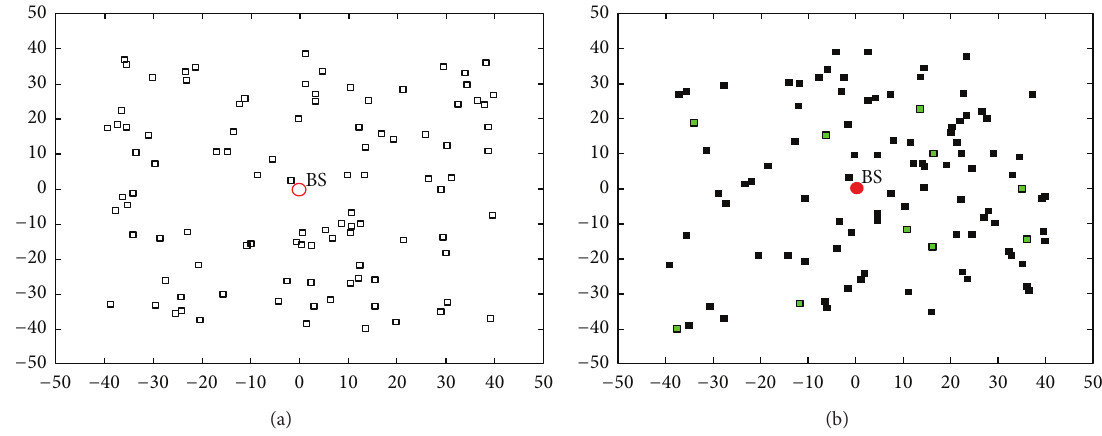
Figure 5: (a) An initial random placement of nodes used in our experimental setup. (b) Randomly selected CH by the initial solution of PSO.